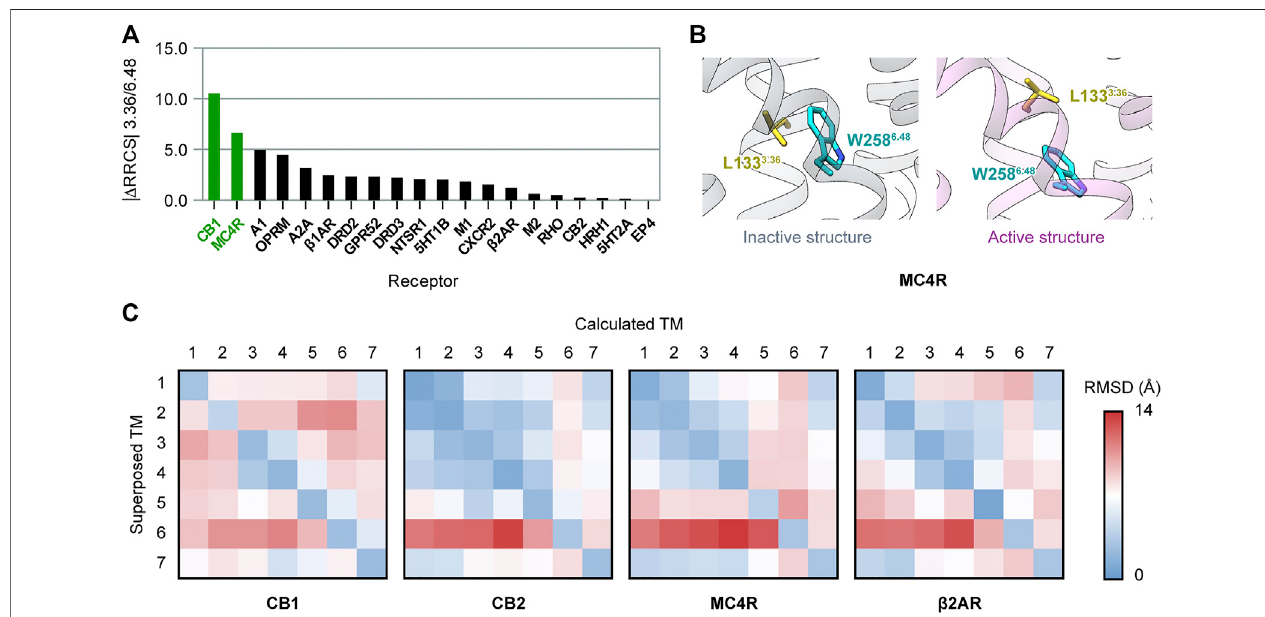
FIGURE5| ComparisonofactivationmechanismsamongclassAGPCRs. (A) Differenceof3.36/6.48residue – residuecontactscore(RRCS)ininactiveandactive structures in class A GPCRs. The top two ranked receptors, CB1 and MC4R, have the “ twin toggle switch ” of 3.36/6.48. (B) “ Twin toggle switch ” of L133 3.36 and